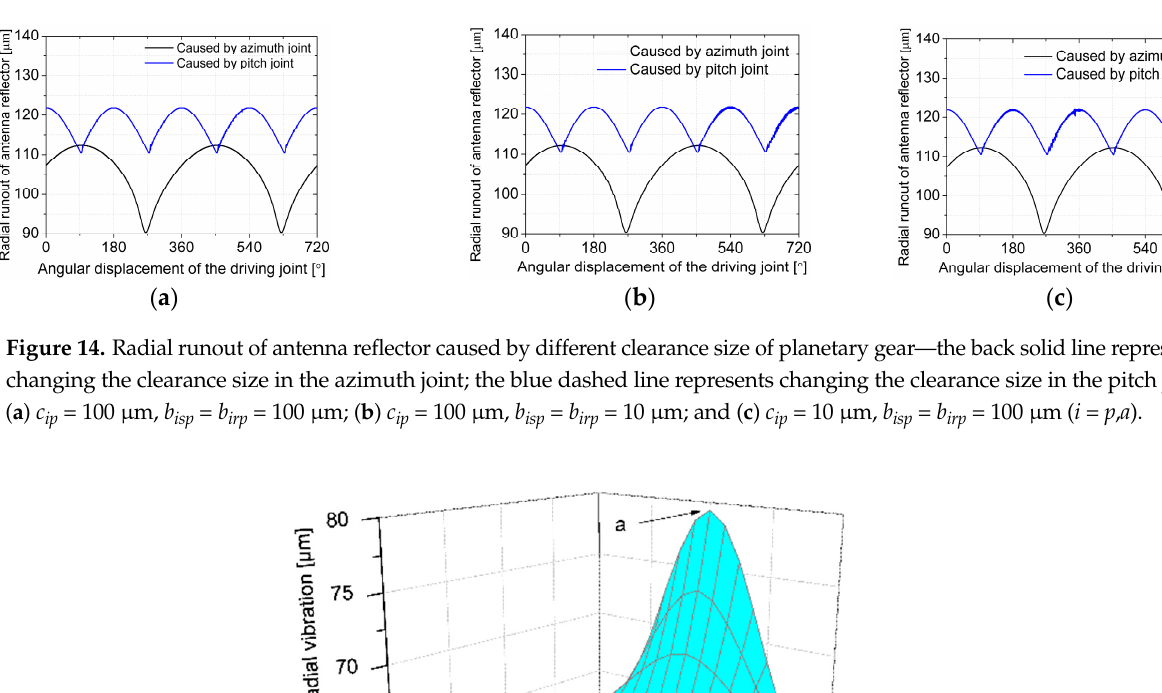
( c ) Figure 12. Tracking speed error of antenna reflector caused by different clearance size of planetary gear in azimuth joint: ( a ) c ap = 100 μ m, b asp = b arp = 100 μ m; ( b ) c ap = 100 μ m, b asp = b arp = 10 μ m; and ( c ) c ap = 10 μ m, b asp = b arp = 100 μ m. ( a ) ( b ) ( c ) Figure 13. Tracking speed error of antenna reflector caused by different clearance size of planetary gear in pitch joint: ( a ) c pp = 100 μ m, b psp = b prp = 100 μ m; ( b ) c pp = 100 μ m, b psp = b prp = 10 μ m; and ( c ) c pp = 10 μ m, b psp = b prp = 100 μ m. The radial runout curves of the antenna reflector at the different coupling between radial clearances and backlash in planetary gears are analyzed. As shown in Figure 14, whether driving by the azimuth joint or the pitch joint, the radial runout curves of the antenna reflector have similar trends under the respective three sets of clearances. Alt- hough the maximum standard deviation of radial runout amplitude caused by the clear- ance coupling in the azimuth joint is 6.4 μ m, which is twice as much as that caused by the pitch joint, but the maximum value of the three back solid curves is close to 112 μ m, that is, close to the minimum value of the three dashed lines. So it can be seen that the effect of coupling between radial clearances and backlash in the azimuth joint on the radial runout